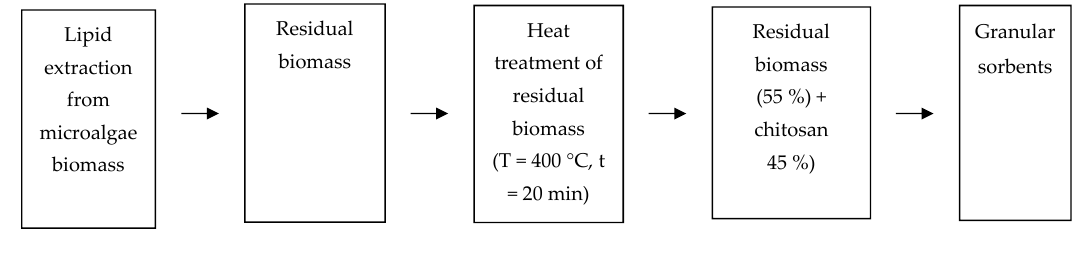
Figure 2. Experiment design.